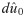
Simplified eclipse models.Simulation results for a chain without chain-chain interactions and a static object (solid blue line) are compared to estimates for F∞ of the “rod” (dashed cyan line) and “terminating-segments” (dashed magenta line) models, also for a chain without chain-chain interactions. The static object is located at du^0, where d = 41.45 nm, and Ro = 23 nm. For comparison, we plot simulation results for a chain with chain-chain interactions and the same static object parameters (solid green line), and a chain with chain-chain interaction and an on-chain object (solid read line). The on-chain object is located at K = 94 bp (denoted by a circle).